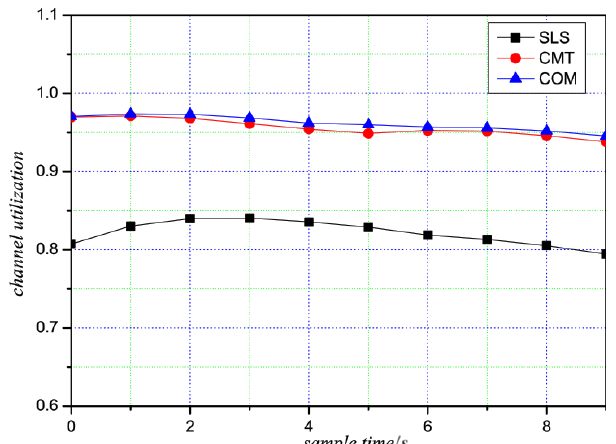
Figure 6. Application benefit of the proposed method and other methods.